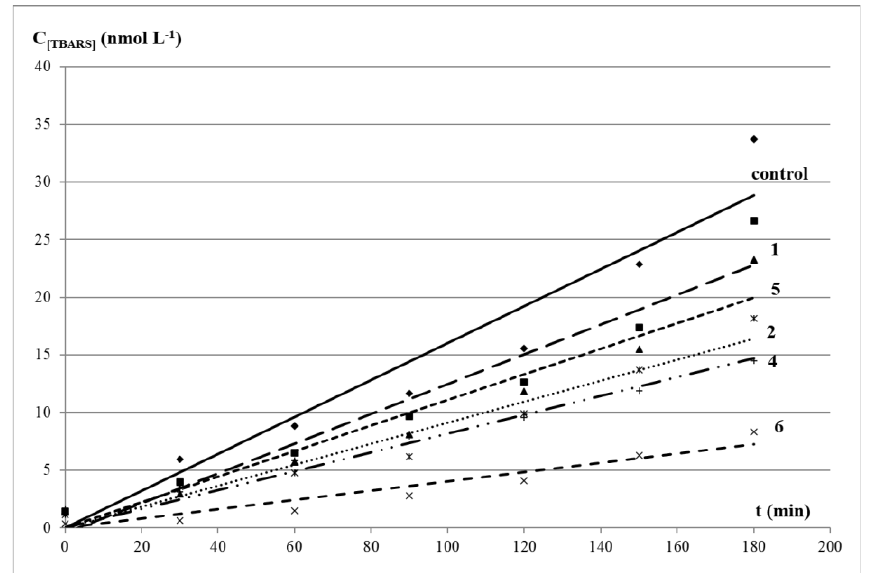
Figure 3. Kinetic curves for the accumulation of TBARS in oleic acid in the presence of 1 mmol/L additives at 65 °C: ( control ) oleic acid without additives; ( 1 ) diphenyl trisulfide; ( 2 ) bis(2-methoxyphenyl) disulfide; ( 4 ) 4,4′ -dihydroxydiphenyl disulphide; ( 5 ) diphenyl disulfide; ( 6 ) bis(3,5-di- tert -butyl-4-hydroxyphenyl) disulphide.